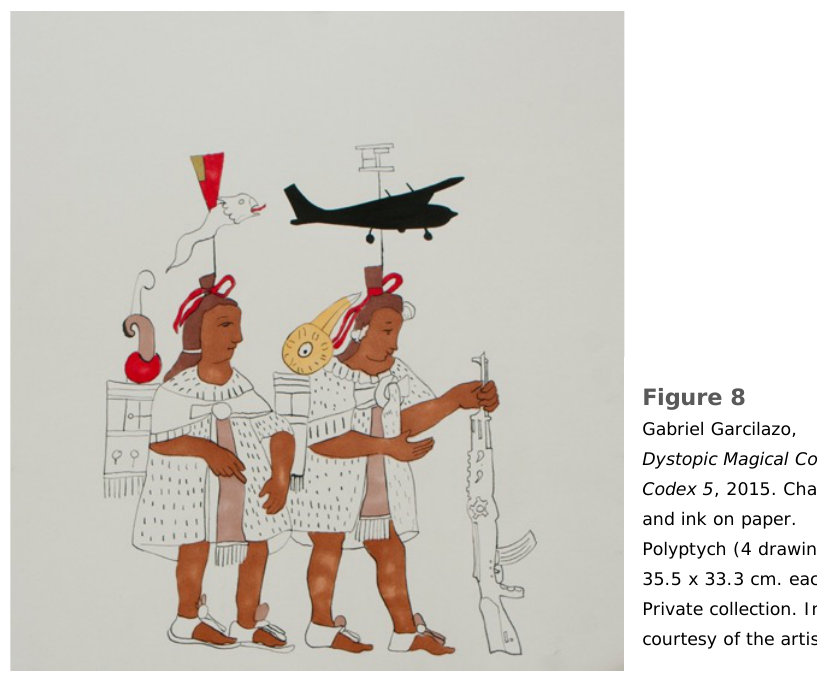
Figure 8 Gabriel Garcilazo, Dystopic Magical Codex: Codex 5 , 2015. Charcoal and ink on paper. Polyptych (4 drawings), 35.5 x 33.3 cm.